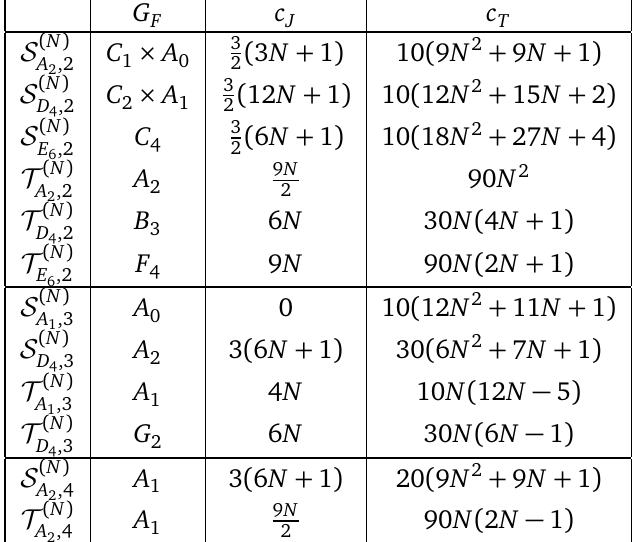
( N ) ( N ) and T theories) and a specific G , k G , k . F G c F